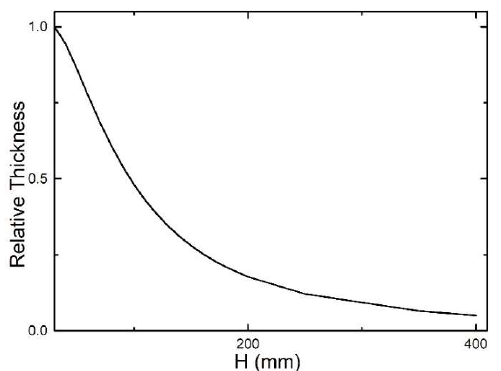
Figure 15. Relative film thickness distribution at different heights.